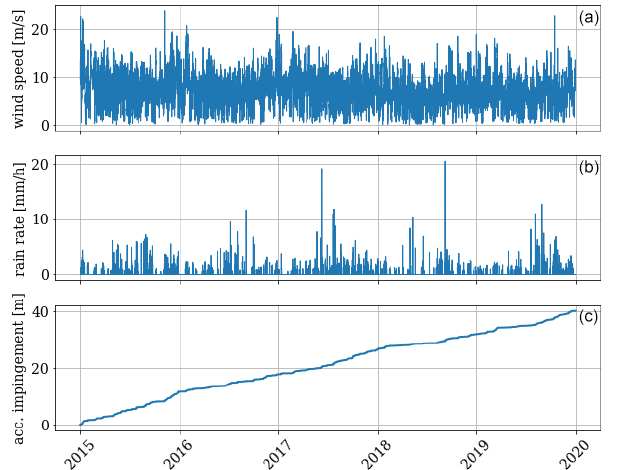
Figure 4. Example of a 5-year time series of wind speed (a) , rain (b) , and accumulated rain impingement (c) from one of the training